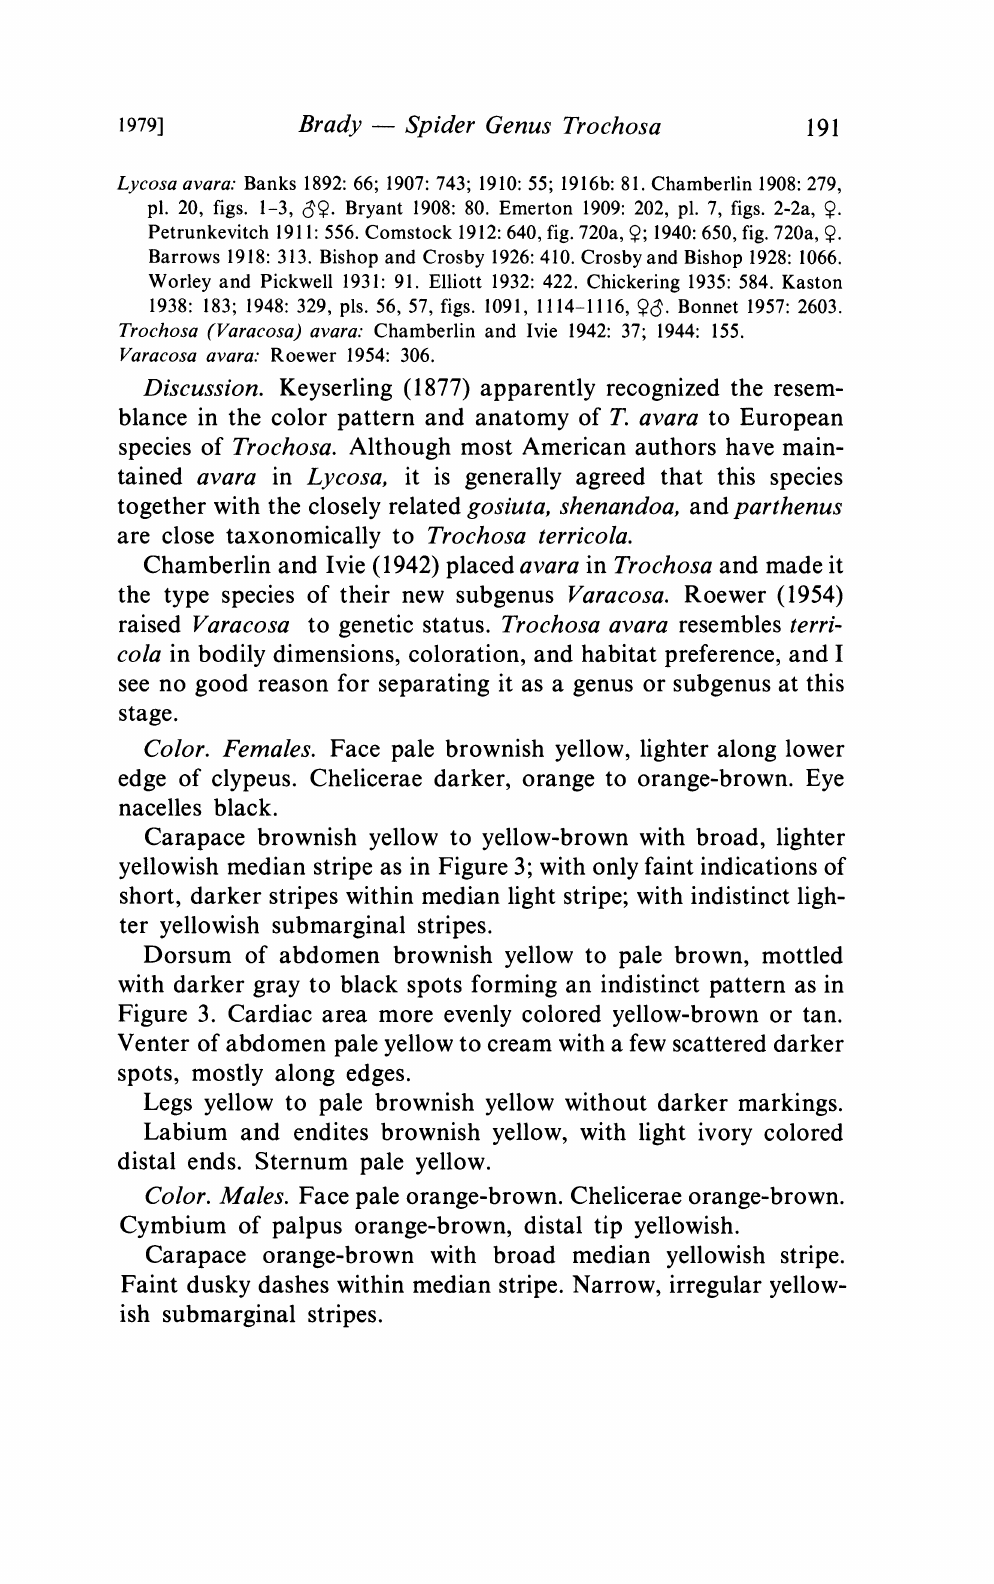
Figure 3. Cardiac area more evenly colored yellow-brown or tan. Venter of abdomen pale yellow to cream with a few scattered darker spots, mostly along edges. Legs yellow to pale brownish yellow without darker markings. Labium and endites brownish yellow, with light ivory colored distal ends. Sternum pale yellow. Color. Males. Face pale orange-brown. Chelicerae orange-brown. Cymbium of palpus orange-brown, distal tip yellowish. Carapace orange-brown with broad median yellowish stripe. Faint dusky dashes within median stripe. Narrow, irregular yellow- ish submarginal